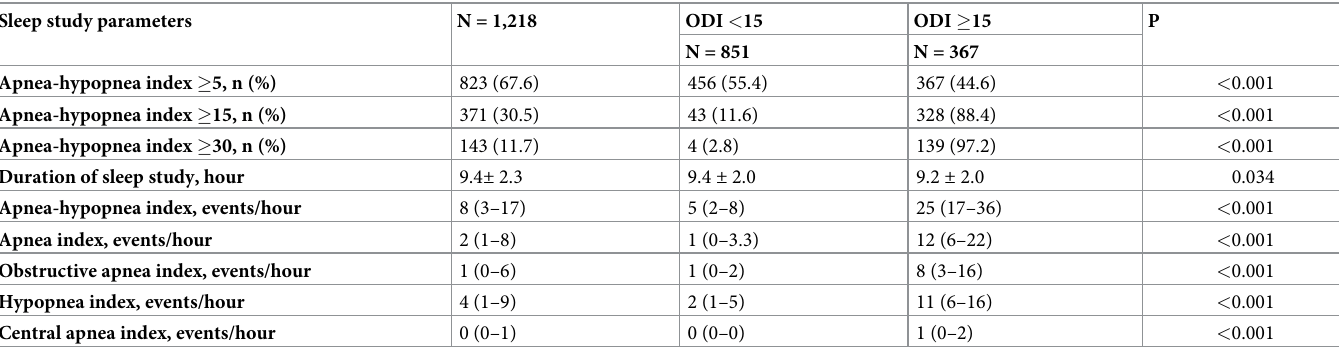
The predictive parameters were estimated for four ODI cut-offs (ODI � 5, � 10, � 15 and � 30 events per hour) against AHI � 15 and � 30 (Table 3). The result showed that ODI � 15 had optimal sensitivity and specificity in predicting moderate-to-severe OSA and severe OSA.